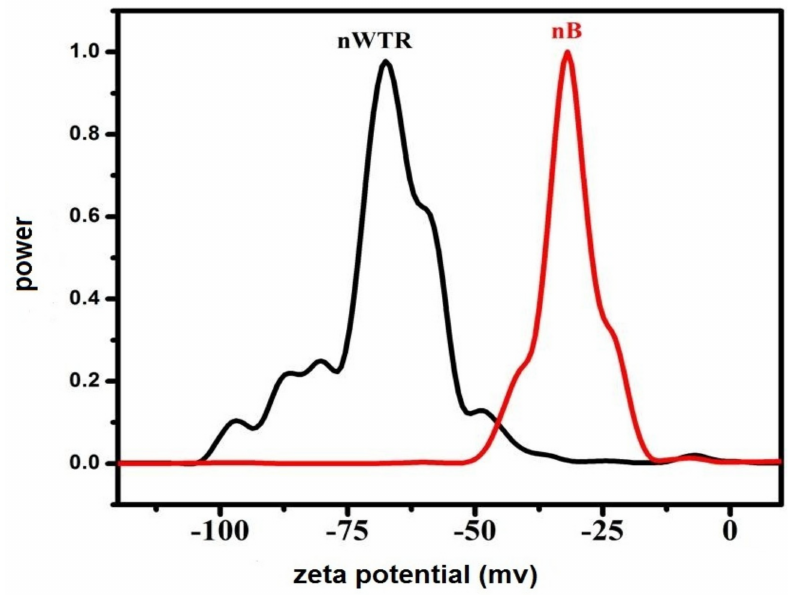
Figure 5. Zeta Potential for nanobiochar (nB) and nanowater treatment residuals